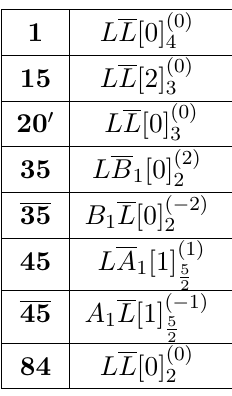
Table 11 . The N = 2 multiplets from level n = 2 .